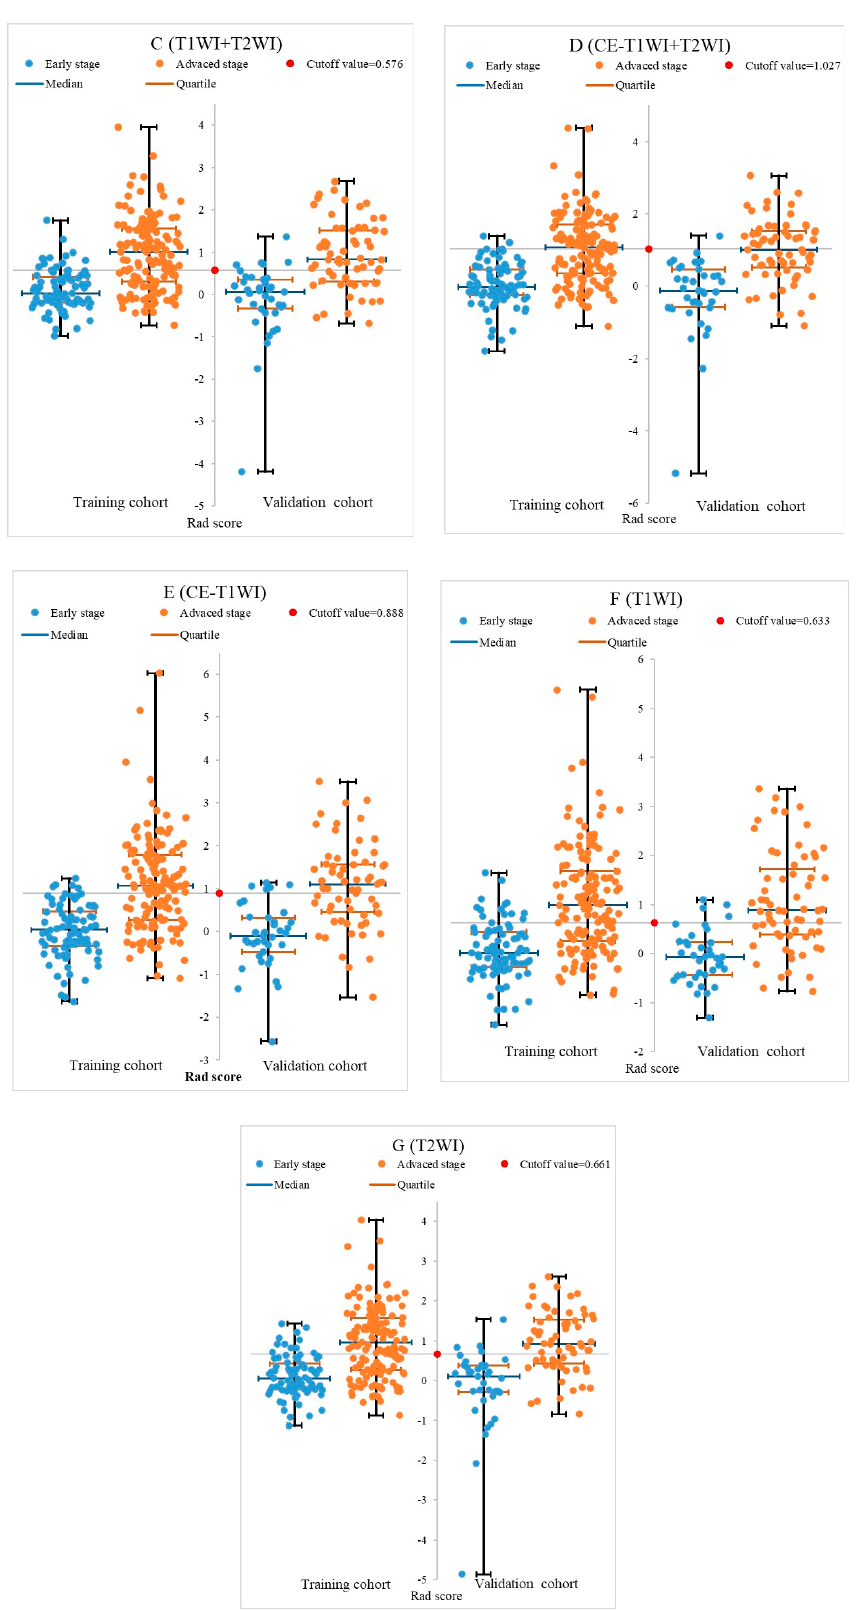
Figure 3. The Rad-scores for each patient in the training and validation cohorts regarding the classification of stage I–II and stage III–IVa NPC. Note: In all radiomics models, the median Rad- scores in the advanced stage were all higher than those in the early